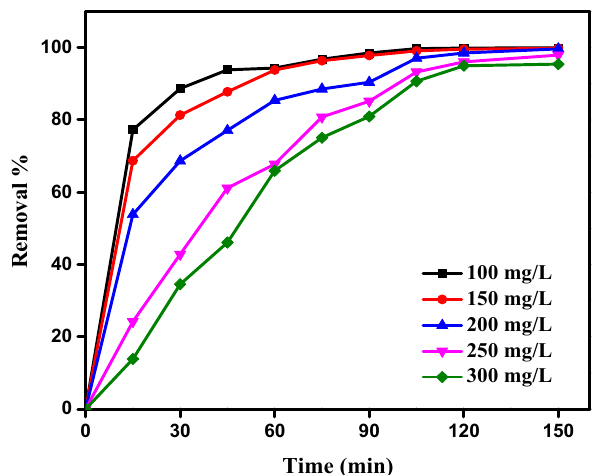
Figure 7. The AY11 dye adsorption for 150 min using PPAC [AY11 dye (100–400 mg/L), PPAC dose (0.75 g/L), Temp. (25